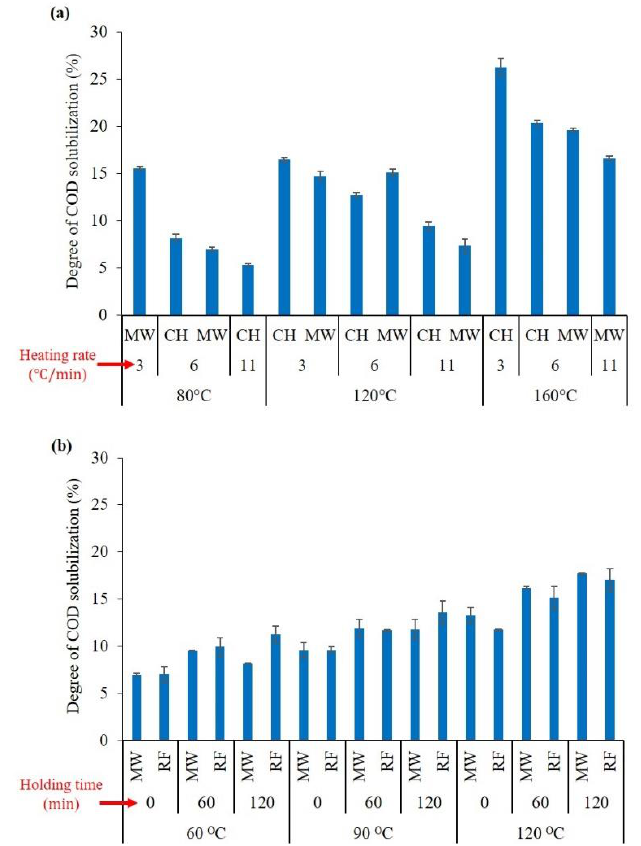
Figure 1. Comparison of CH, MW, and RF pretreatments for the solubilization of COD from; ( a ) CH vs. MW study and ( b ) MW vs. RF study.